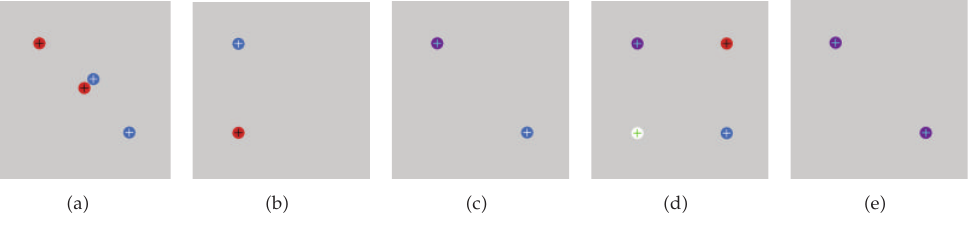
Figure 15: Ground-truth location of critical